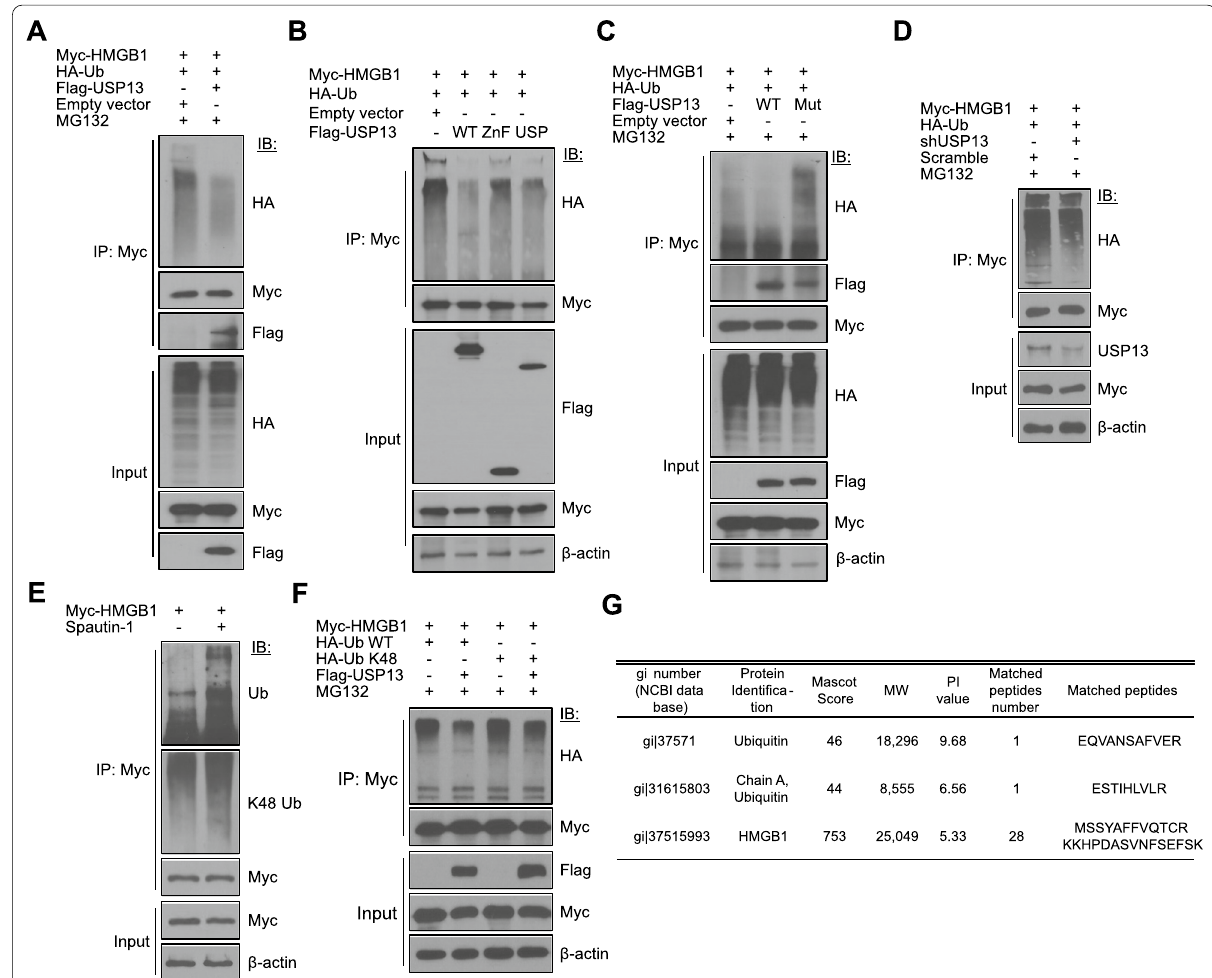
Fig. 3 USP13 deubiquitinates HMGB1. A , B HEK293T cells were co‑transfected with Myc‑HMGB1, HA‑Ub, and Flag‑USP13 plasmids ( A , N 2) and = with Myc‑HMGB1, HA‑Ub, Flag‑USP13 wildtype (WT), ZnF or USP domain plasmids ( B , N 2) for 48 h. The cells were treated with 10 μM MG132 for = the last 18 h before harvesting the cells. WCLs were immunoprecipitated (IP) and immunoblotted (IB) with the indicated antibodies. C HEK293T cells were co‑transfected with indicated plasmids for 48 h and treated with MG132 for the last 18 h. Flag‑USP13 WT and inactive USP13C345A/ M664/739E (USP13 Mut) plasmids were used (N 2). Data represents one of two similar independent experiments in A – C , respectively. D HEK293T = cells were co‑transfected with indicated plasmids for 48 h and treated with MG132 for the last 18 h. shUSP13 was used to knock down